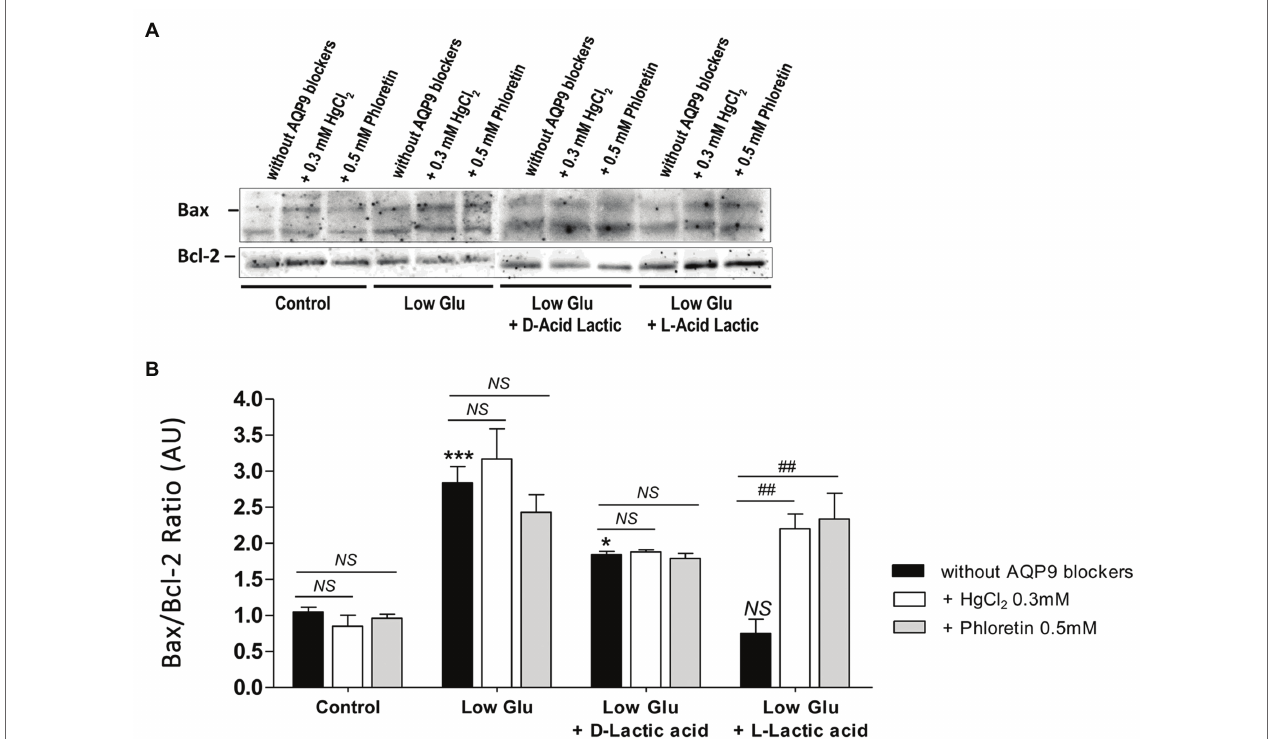
FIGURE 2 | Bax and Bcl-2 expression. (A) Representative Western Blot images and (B) densitometry for Bax/Bcl-2 ratio in placental explants cultured in the different conditions: Control (25 mM glucose medium), Low Glucose medium (Low Glu, 5 mM glucose), Low Glucose medium with D-Lactic acid, and Low Glucose medium with L-Lactic acid. The effect of 0.5 mM Phloretin or 0.3 mM HgCl 2 to block AQP9 was evaluated in all the treatments. Data are expressed as means ± SEM. n = 6 placentas. (* p < 0.05, *** p < 0.001 compared to control without AQP9 blockers, NS = Non-significant; and ## p < 0.01 compared to low glucose medium with L-lactic acid without AQP9